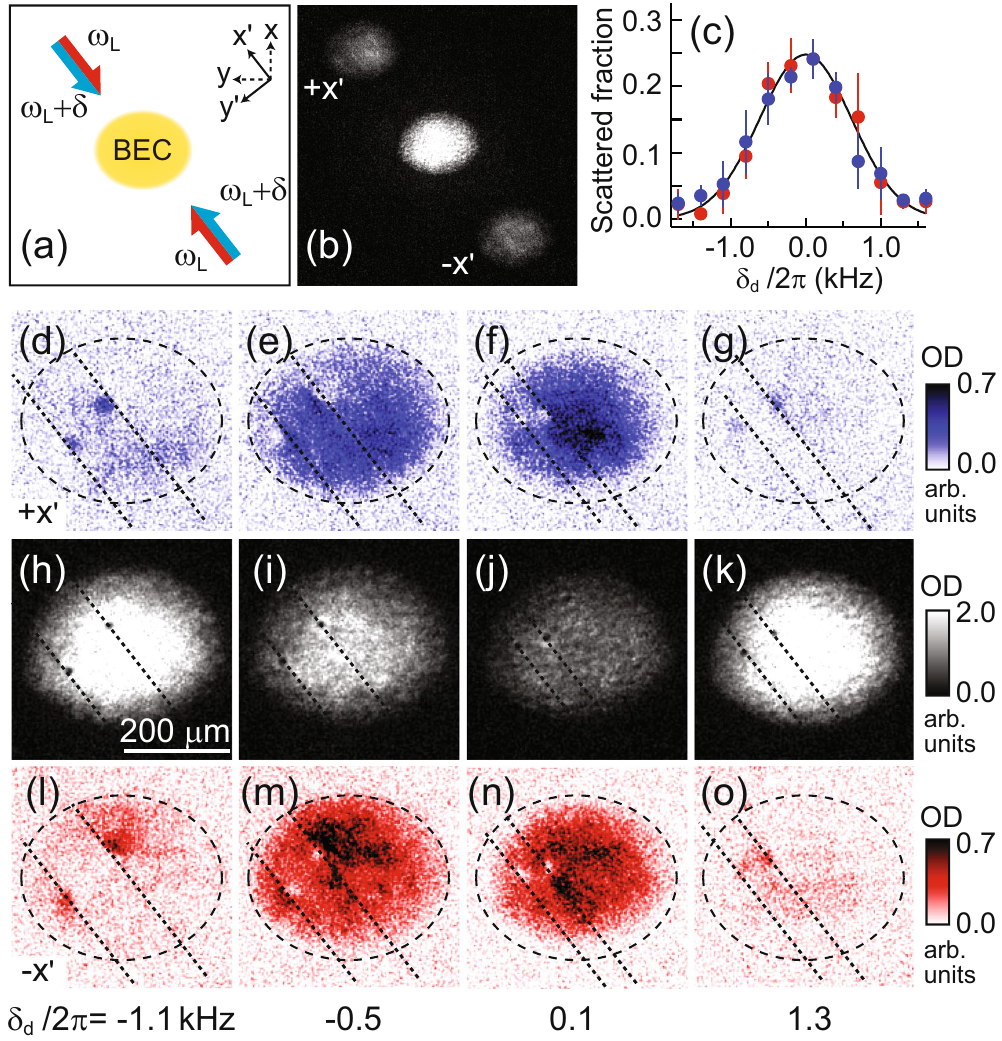
Figure 3. Spatially resolved Bragg spectroscopy of a BEC. ( a ) Schematic of the experimental setup employing two pairs of counterpropagating Bragg beams. ( b ) Example of Bragg spectroscopy image for δ d /2 π = 0.4 kHz. Two atomic clouds are dispersed from the BEC in the ± x ′ directions. ( c ) Scattered-out atom number fractions measured for a stationary BEC as a function of δ d . The blue and red circles denote the atom number fractions of the + x ′ -and − x ′ -scattered atom clouds, respectively. The curved line is a Gaussian function of 2 2 fit to the data, where A = 0.25, δ π = 99.2 kHz, and δ π = 615 Hz. δ δ δ δ − − A exp[ ( ) /(2 )] 0 /2 w /2 w is accounted w 0 for by the finite pulse broadening. Bragg responses of a BEC having a vortex dipole for various frequencies δ d : ( d – g ) + x ′ -scattered atom clouds; ( h – k ) remaining condensates; and ( l – o ) − x ′ -scattered atom clouds. The dashed lines denote the boundary of the initial BEC, and the dotted lines indicate the Bragg beam lines that pass the vortex cores. The circulation signs of the vortices are known based on their trajectories in the trapped BEC, and the upper-right (lower-left) vortex has a positive (negative)